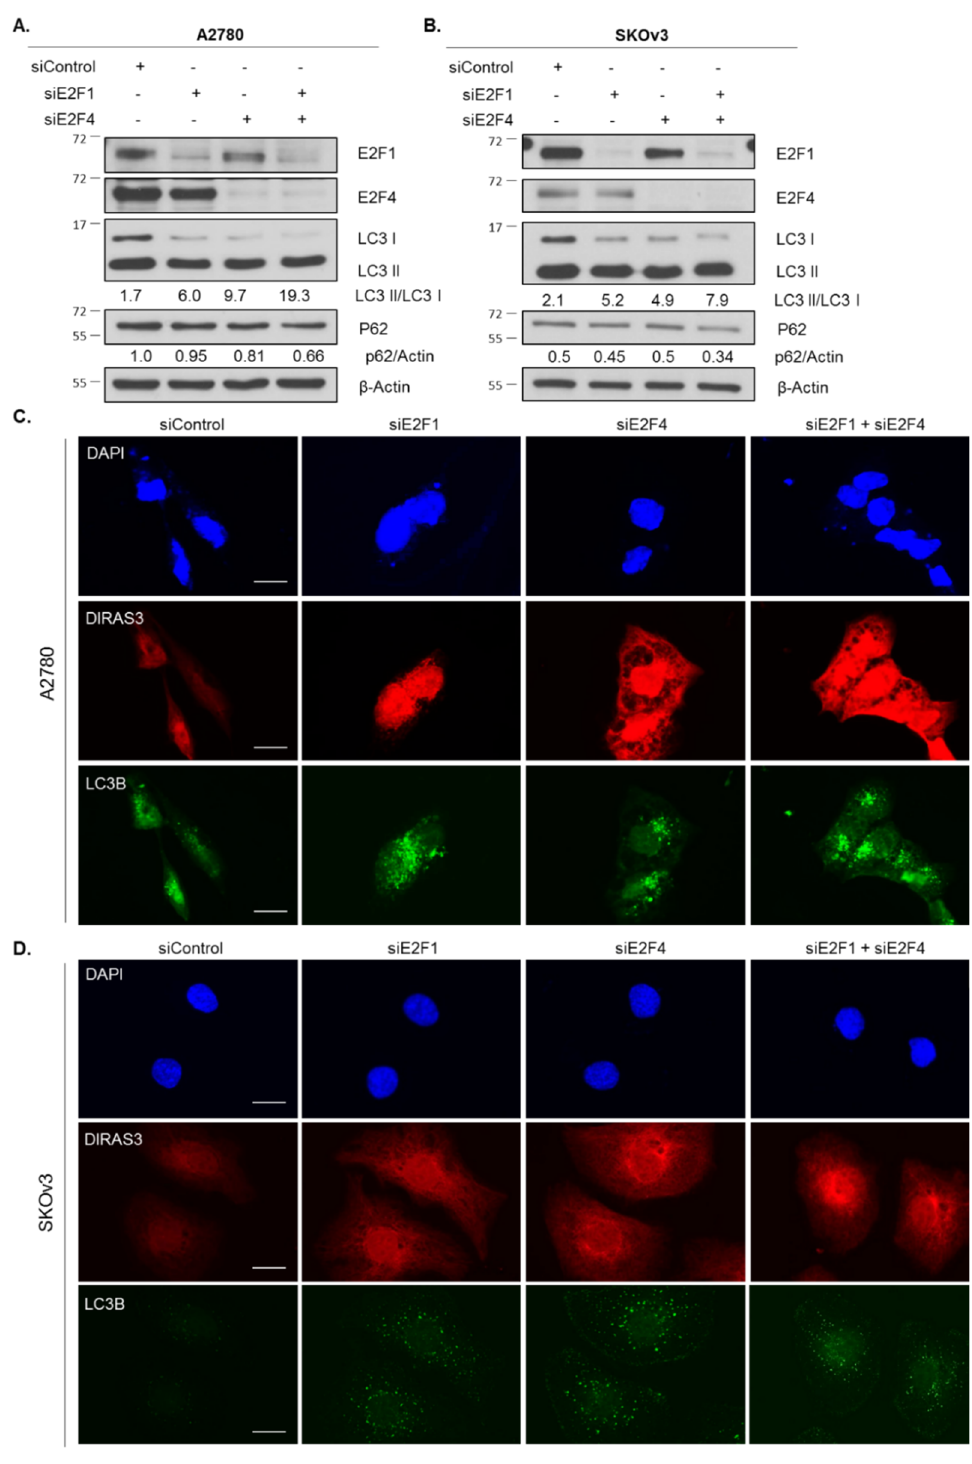
Figure 5. Knockdown of E2F1 or E2F4 phenocopies amino acid starvation-induced upregulation of DIRAS3-mediated autophagy. A2780 ( A ) and SKOv3 ( B ) ovarian cancer cells were treated with control or targeted siRNA for 72 h. Protein lysate was collected and western blot analysis was performed. Blots were probed as indicated. Immunofluorescence staining was performed on A2780 ( C ) and SKOv3 ( D ) cells following control or targeted siRNA treatment as previously described. DAPI was used to stain the nucleus. Scale bars indicate 15 µ m (A2780 and 5 µ m (SKOv3)). Raw data films for western blot analysis shown in Figure